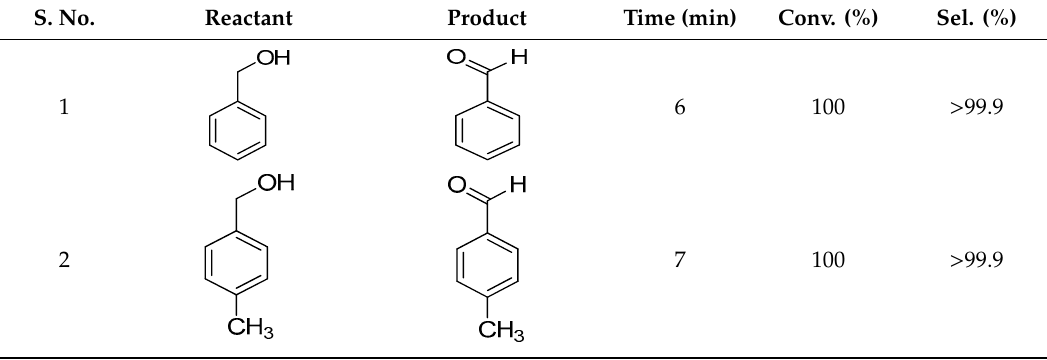
3 –(1%)ZrO 2 . Table 4. Aerobic oxidation of various alcohols catalyzed by (1%)NDG/MnCO